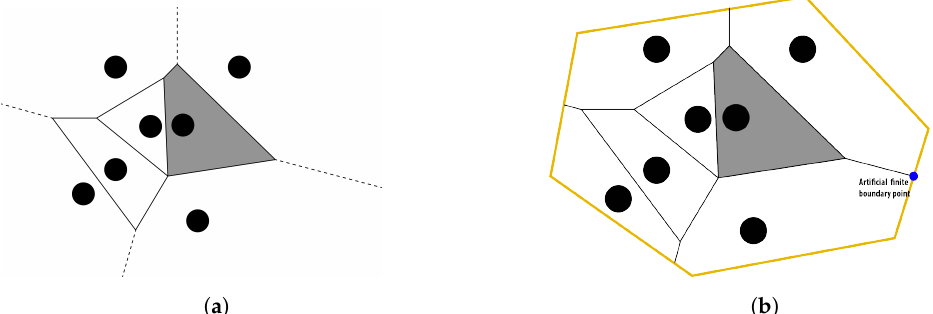
Figure 8. Voronoi tessellation ( a ) with infinite boundaries element and ( b ) with finite user defined